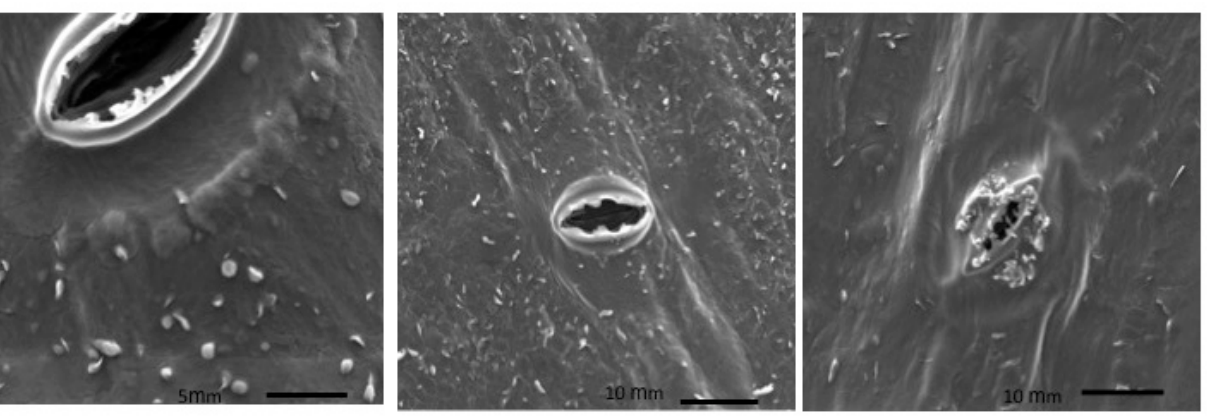
Figure 1 . ESEM microscopy showing bacteria associated with the stomata of different cultivars (A) Monza, (B) Menorca and (C) Unipak